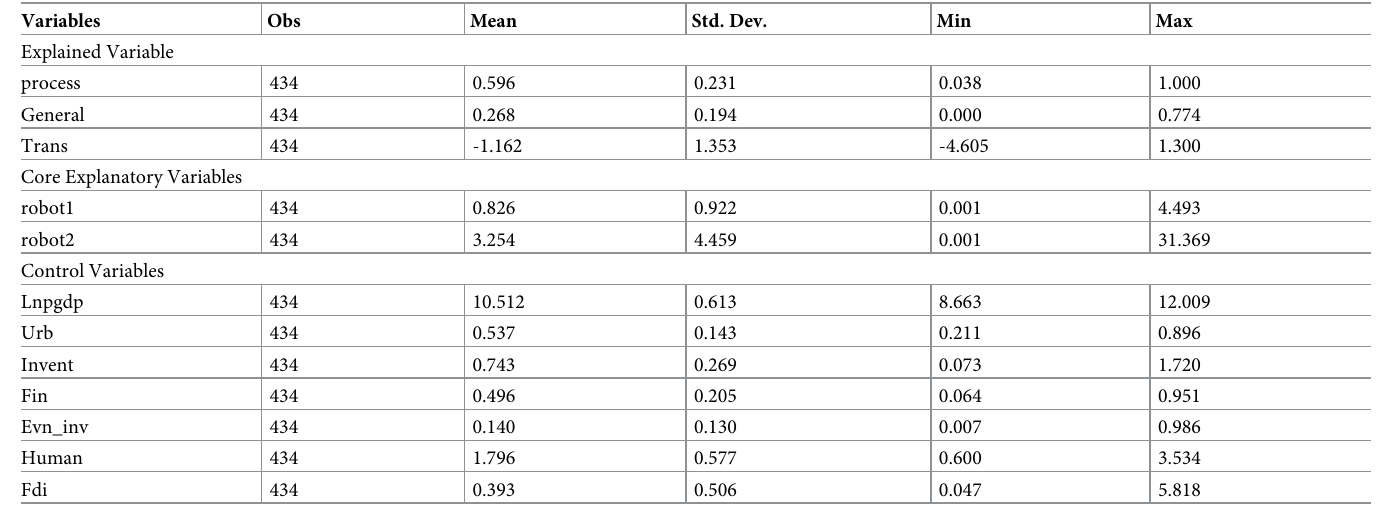
Table 1. Descriptive statistics of variables.